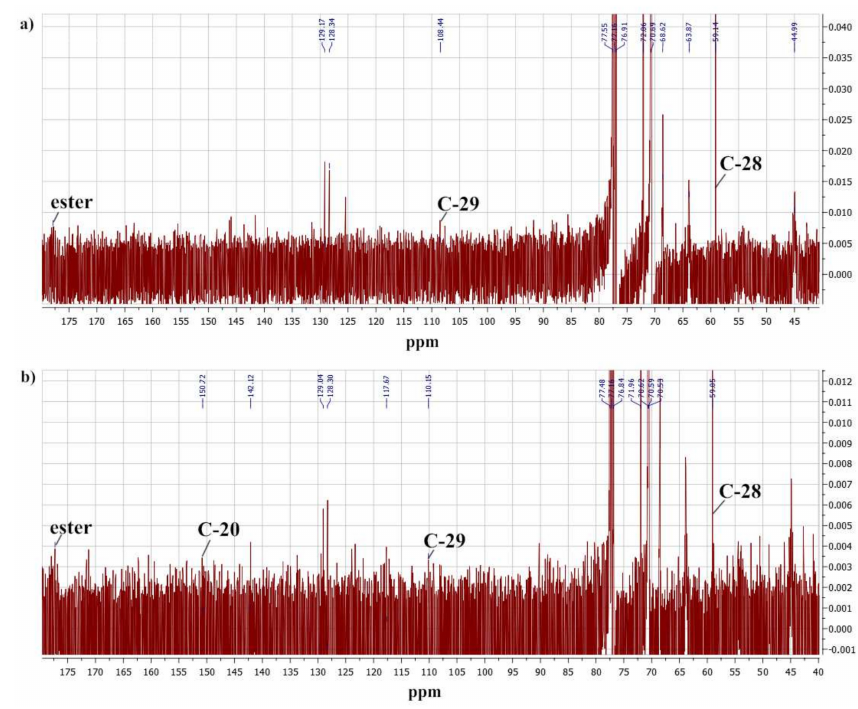
Figure 3. Fragments of the 13 C NMR spectra of Bet-1 ( a ) and Bet-2 ( b ) copolymers.